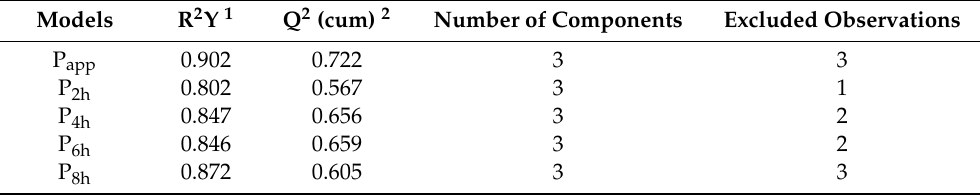
Table 2. Statistical Parameters in Partial Least Squares (PLS) regression